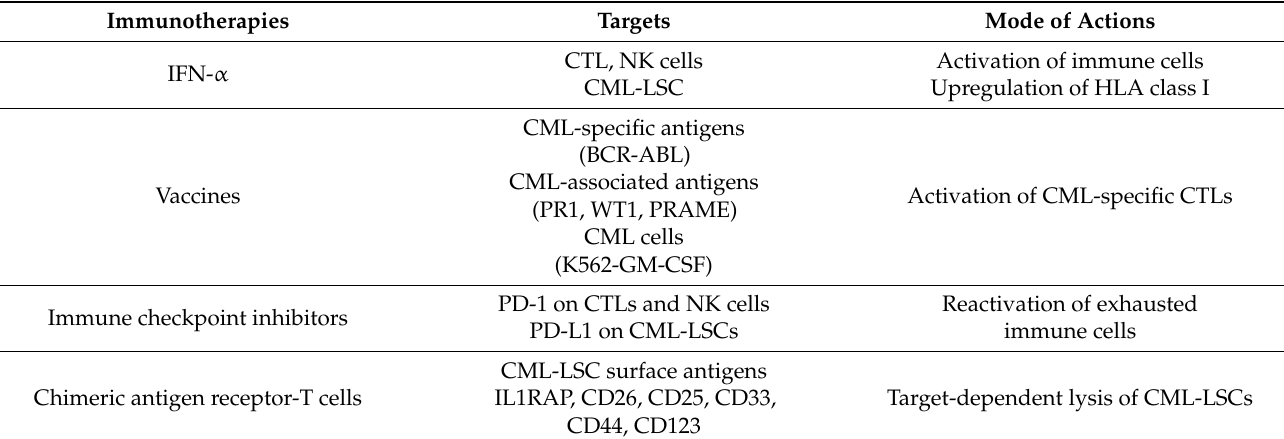
Table 2. New immunotherapies for targeting